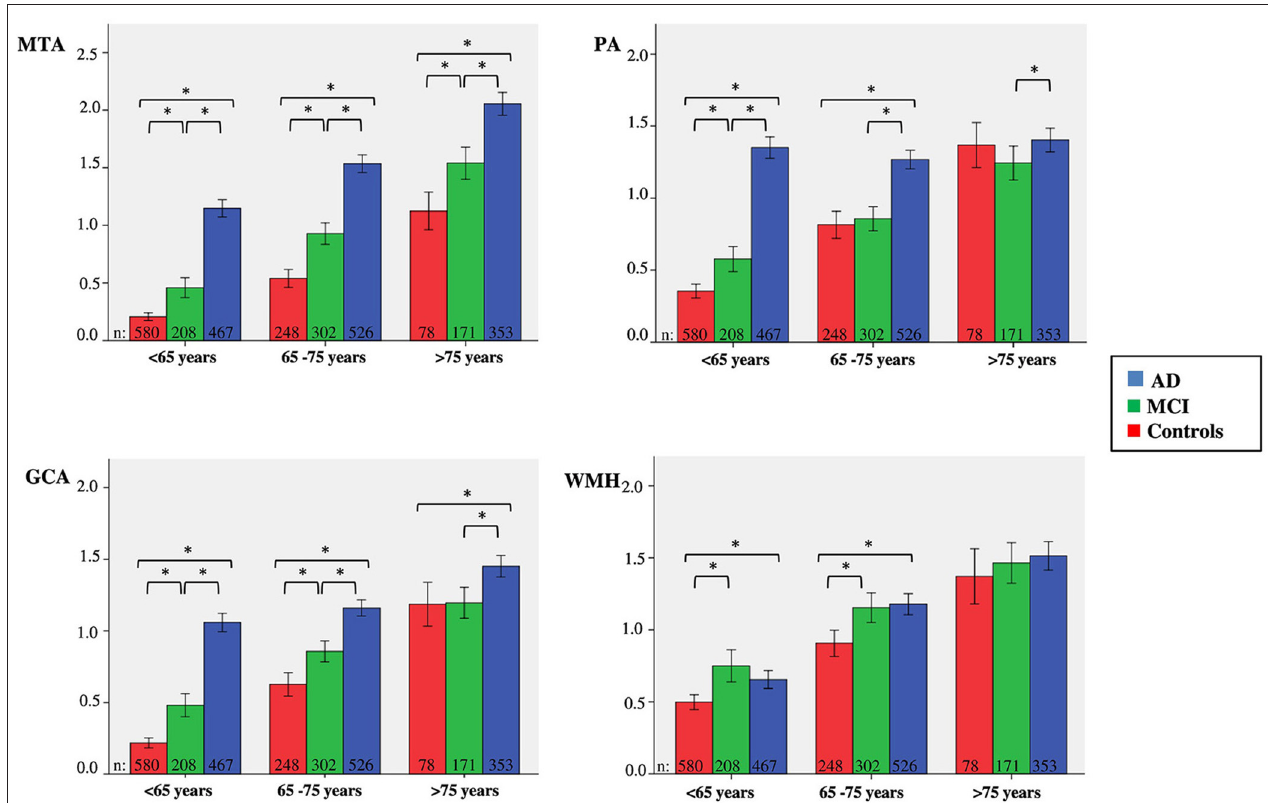
FIGURE 2 | Clustered bars showing mean MTA, PA, GCA, and WMH scores for age group according to baseline diagnosis. Y-as: respectively mean MTA (left + right/2), PA (left + right/2), GCA, and WMH, X-as: age group, 95% confidence interval is presented by the error bars, *indicates significant difference between diagnostic groups, using Kruskal-Wallis tests and post-hoc Mann-Whitney U -tests.